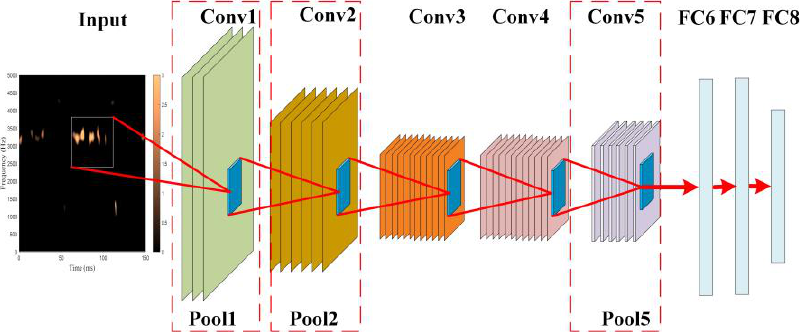
Figure 4. AlexNet network model.